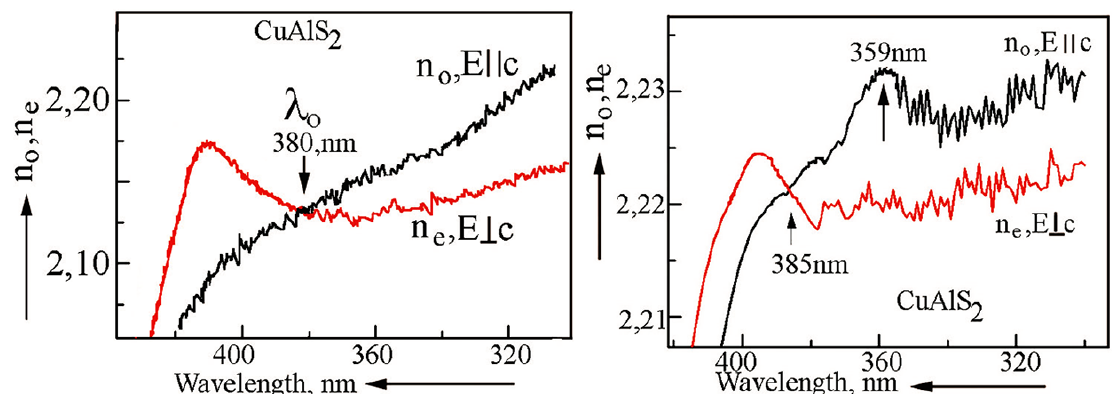
Figure 7. Spectral dependences of refractive indices for ordinary and extraordinary waves in CuAlS crystals with thicknesses of 93 µm (left) and 15 µm (right). 2